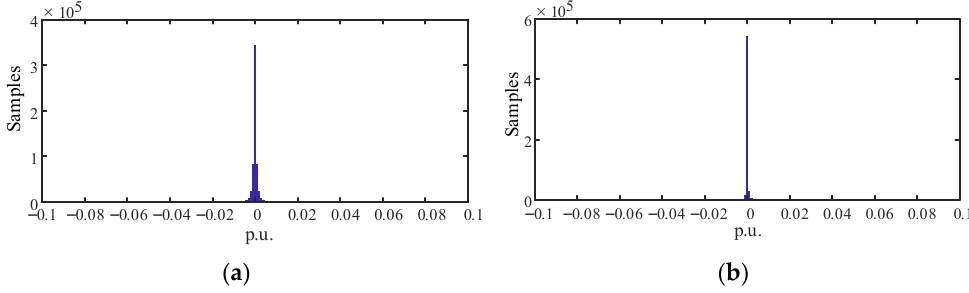
Figure 6. Histogram of measurement variation in November. ( a ) Before power-law transformation. ( b ) After power-law transformation.